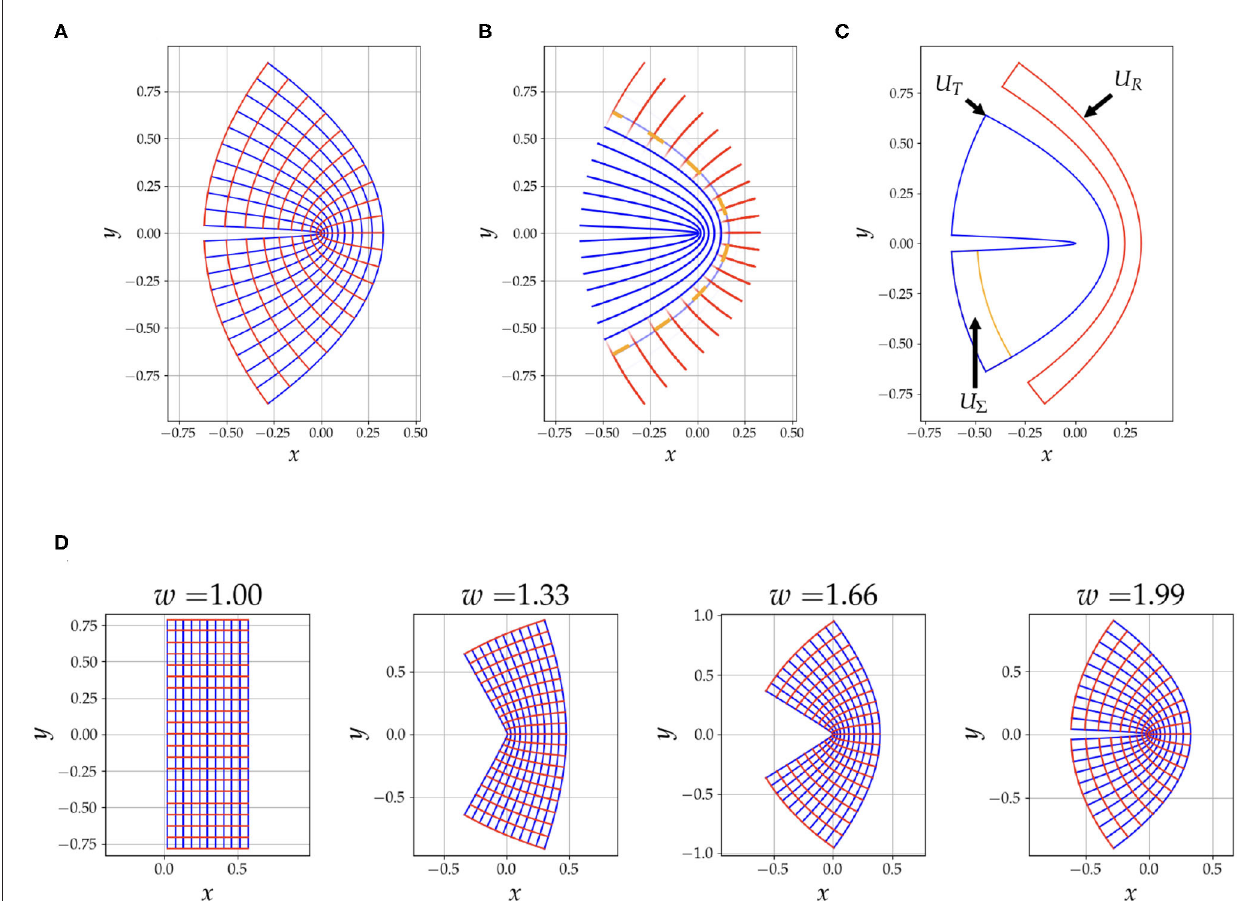
FIGURE 1 | This figure summarizes aspects of our simulation strategy. In (A) , we have an illustration of the conformal coordinate system grid generated by Equation (3) with w = 1.99. In (B) , we have the fibres, blue for tangential and red for radial, used to generate the diffusion signal. Notice that there is an overlap between the two tracts to depict the mixing of the signal from the two compartments, the opacity of the line is calculated from Equation (4). The orange dashed line is u 1 / 2 . In (C) , the region U 6 , is the seeding area, the region U T is the ground truth area occupied by the tangential tracts, and U R is used to detect tracts that falsely traverse into the radial fibres. Notice that U R is half of the region occupied by the radial tracts, this is done to reduce errors introduced by discretization. Also note that U R is asymmetric, this choice is to reject false positives caused by purely radial tracts emanating from U 6 , the focus is intended to be on the bent area. In (D) , we show the effect of changing the parameter w on the curvature of the geometry.